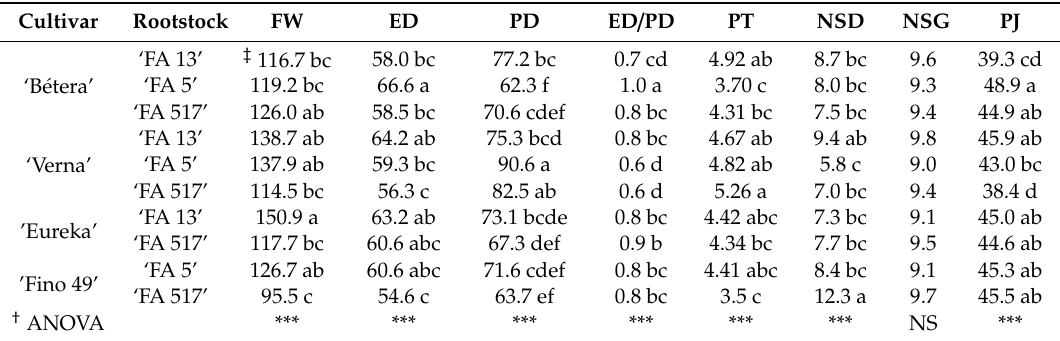
Table 1. E ff ect of di ff erent rootstocks on lemons (‘B é tera’, ‘Verna’, ‘Eureka’ and ‘Fino 49’), average fruit weight (FW, g), fruit equatorial diameter (ED, mm), fruit polar diameter (PD, mm), peel thickness (PT, mm), number of seeds (NSD), number of segments (NSG), volume of juice (VJ, mL) and percentage of juice (PJ,